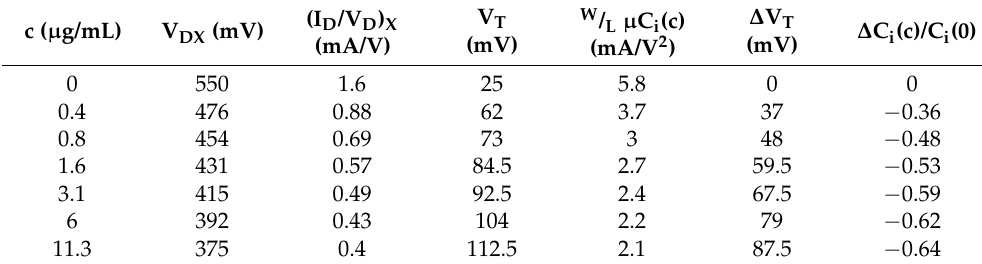
Table 1. Results of quantitative evaluation of the output characteristics, Figure 2: axis intercepts V DX and (I D /V D ) X from the I D /V D vs. V D plot, resulting in V T and W / L µ C i (c) calculated with Equation (3) and Equation (4), and sensor metrics ∆ V T and ∆ C i (c)/C i (0), as defined in Equation (5), against RBD spike concentration, c. c ( µ